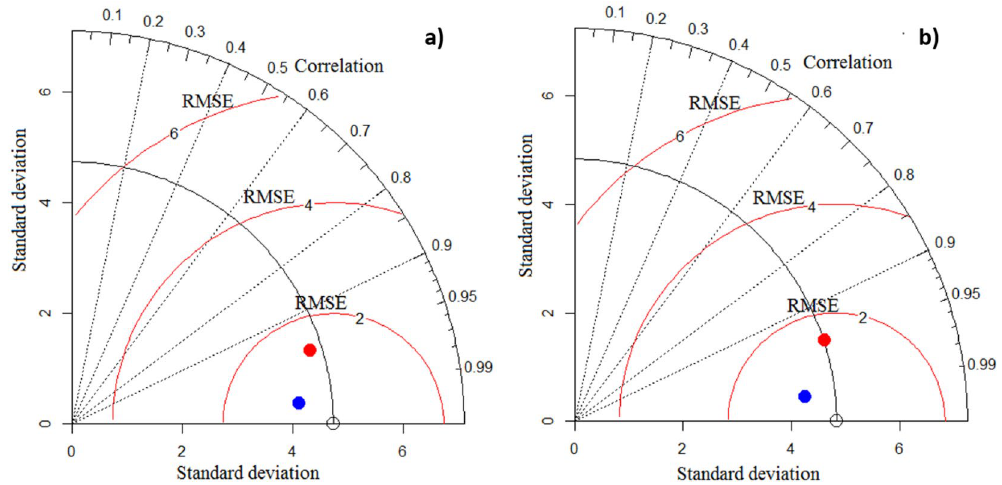
Figure 8. Taylor diagrams for assessment of DL model performance based on: ( a ) the training dataset, and; ( b ) the validation dataset. The red and blue points indicate the DBM and 1DCNN-LSTM hybrid model,